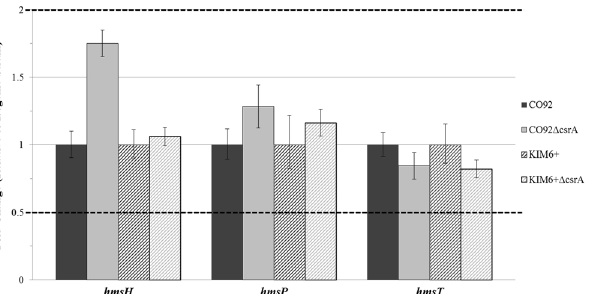
Fig 8. CsrA does not alter Y . pestis hmsH , hmsP , and hmsT Transcript Levels. Relative mRNA abundance of hmsH , hmsP , and hmsT among the csrA -deficient mutants and the respective parental strains calculated via the ΔΔ C T method in reference to the gyrB gene. Dashed lines reflect two-fold thresholds for alterations in relative transcript levels. No significant change in relative mRNA abundance among the deletion mutants and the respective controls were determined by one-way ANOVA comparing the average of 2 independent cDNA samples per strain, each consisting of 3 technical replicates per